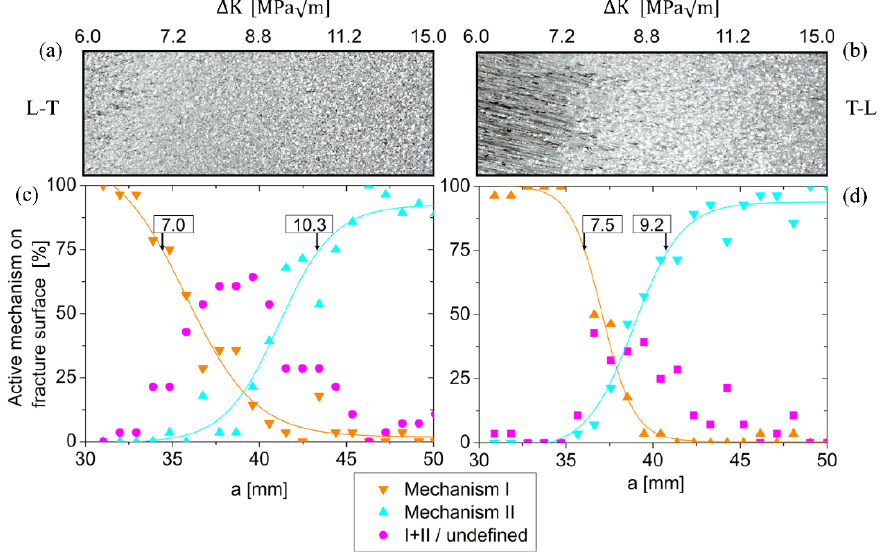
Figure 10. Quantitative analysis of damage mechanisms on the fracture surface of var 3 L-T ( a , c ) and T-L ( b , d ) orientations. Macrographs from the optical microscope of the fracture surfaces are shown at the